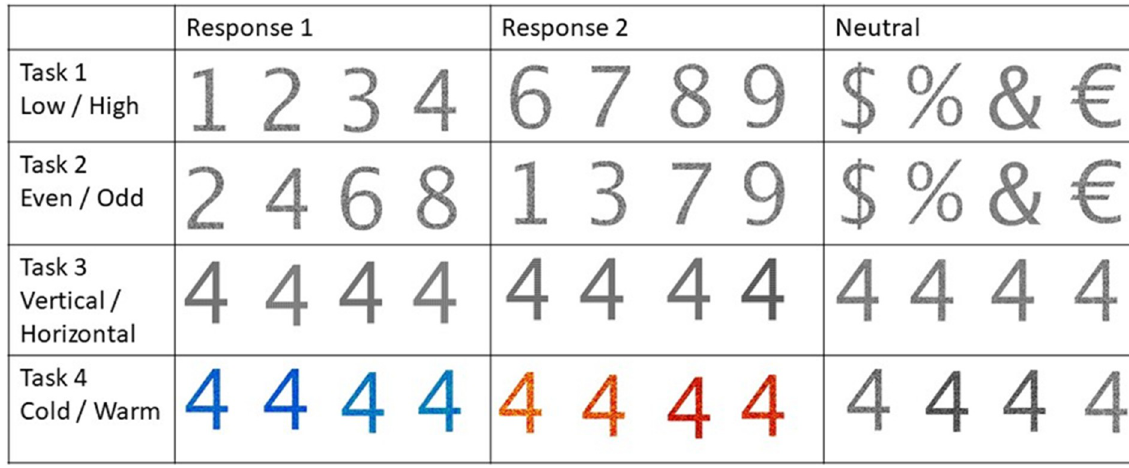
Fig 1. Examples of different stimuli for all subtasks of the DTS protocol.